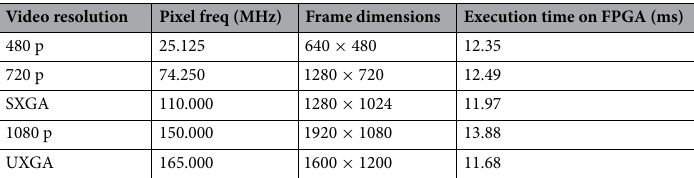
Table 1. Execution time of the bottle classification process at several image resolutions.